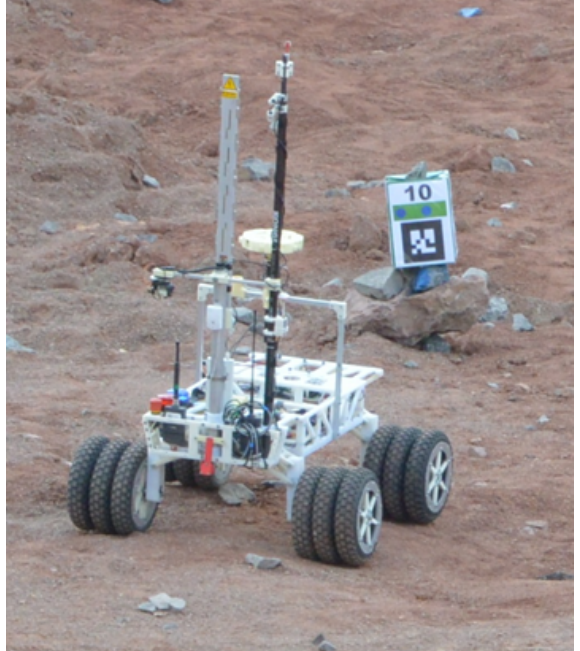
Figure 1. A mobile a vehicle with vision system on the test track. In the background, there is shown ARTag with coded number 10.